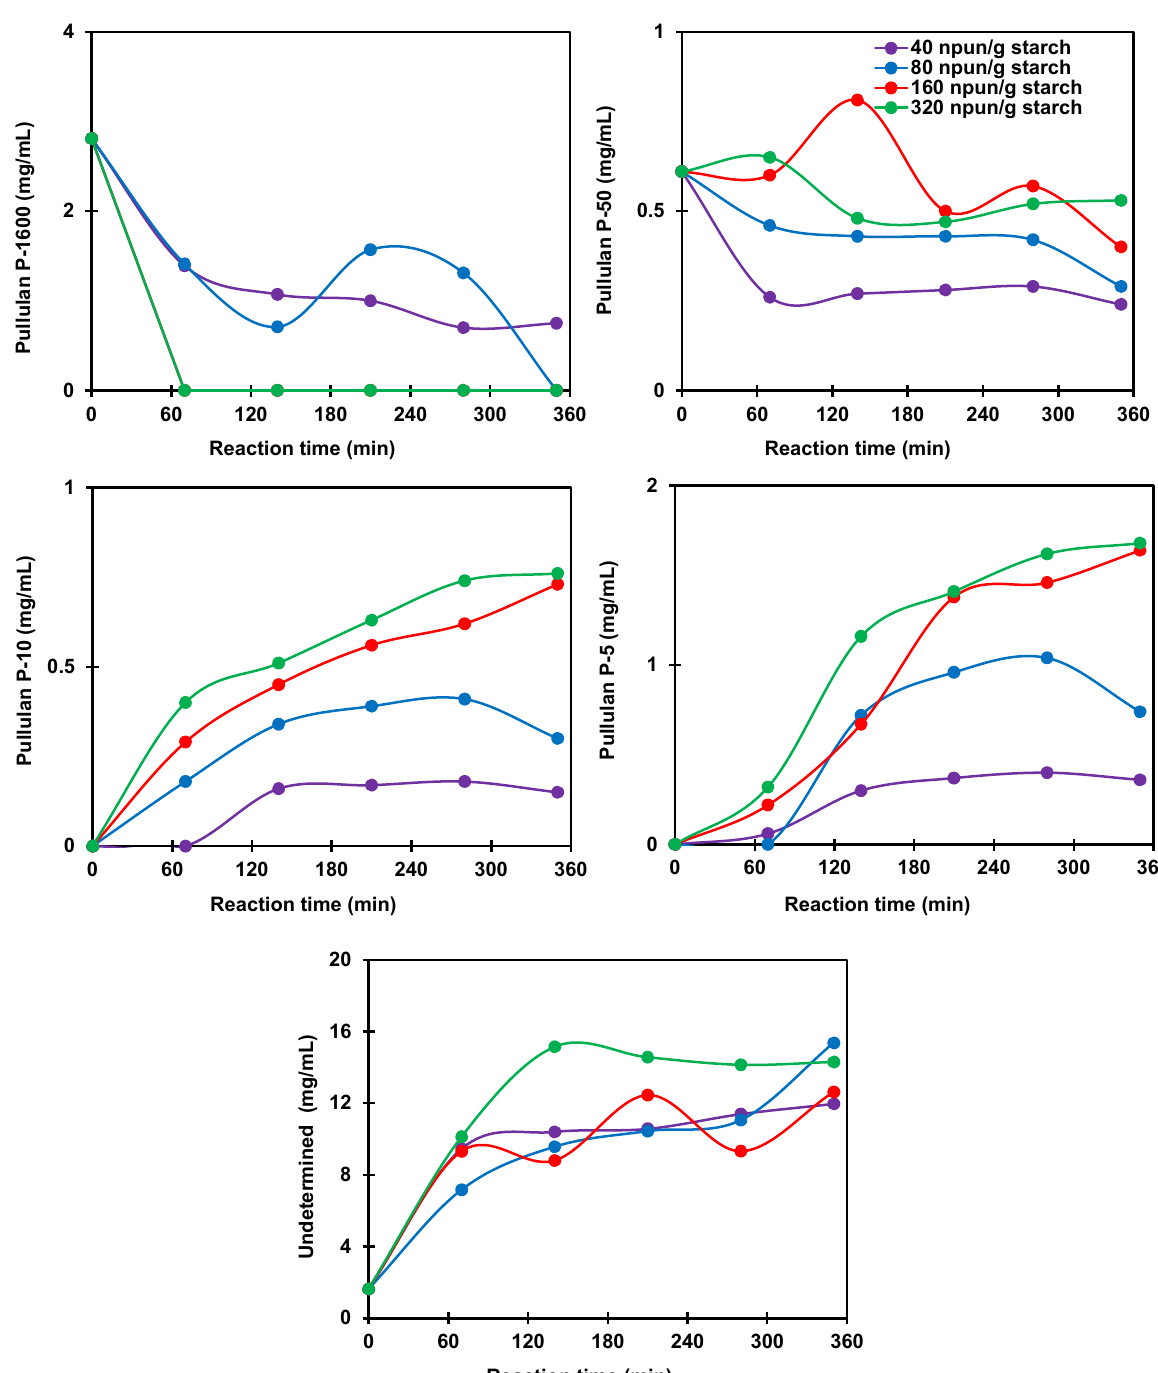
Figure 8. Effects of Pullulanase concentration on the production of hydrolysates containing molecules associated with Pullulan standard molecular weights P1600, P-50, P-10, P-5 and undetermined but lower than P-5 at 40 °C. Lines show trends.